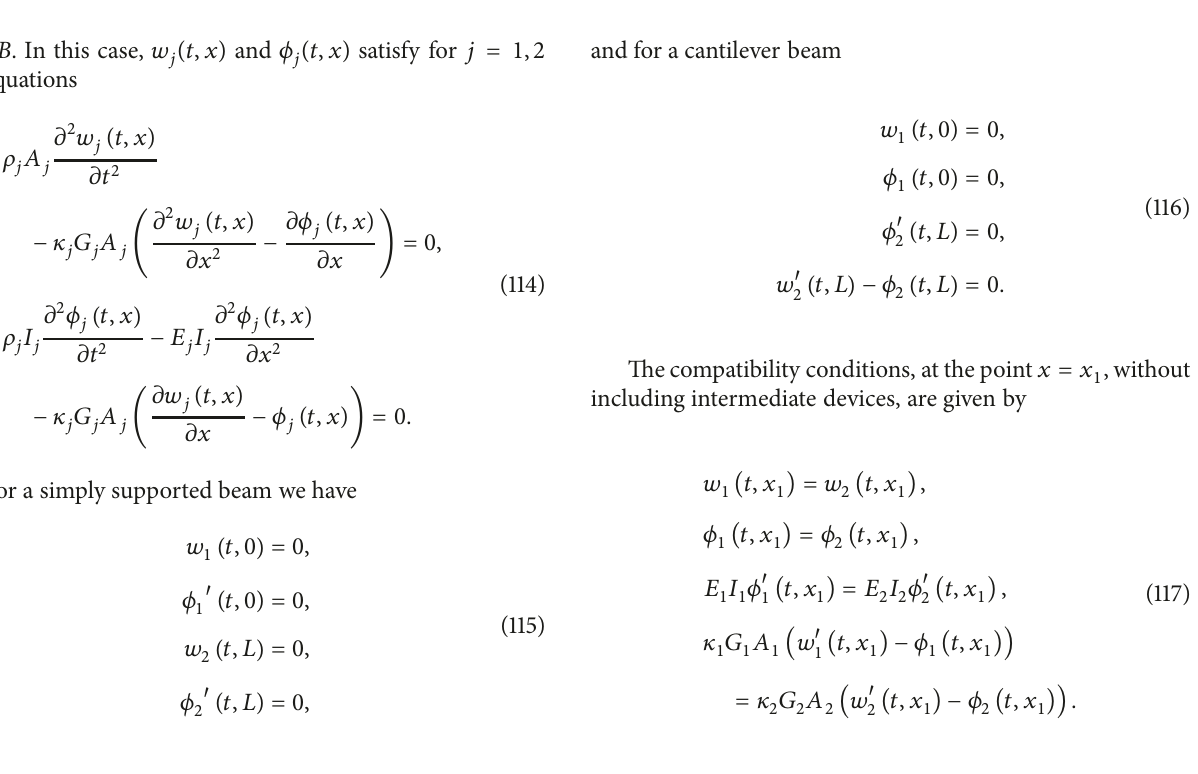
Figure8:Modeshapesofsimplysupportedbeam(firstcolumn)andcantileverbeam(secondcolumn),classicalcase(solidline)andincluding surface effects (dashed